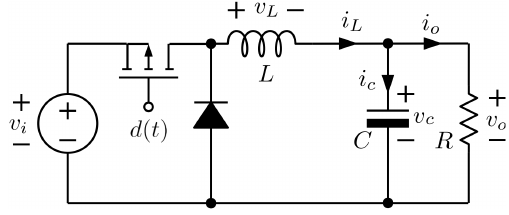
Figure 1. Diagram of the Buck